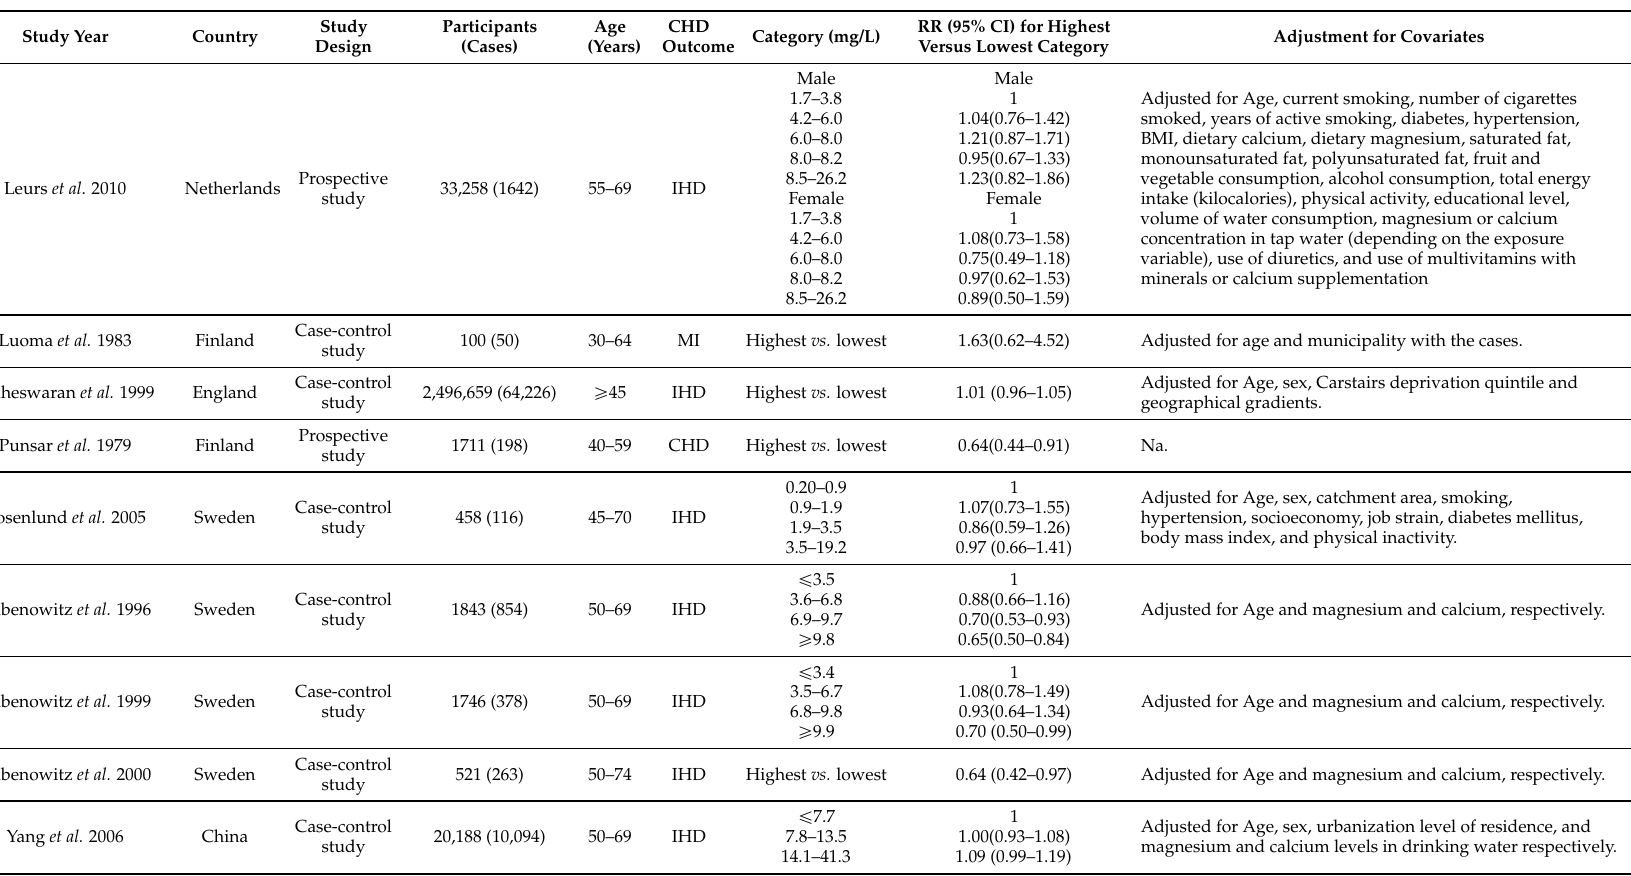
Table 1. Characteristics of studies on the levels of magnesium in drinking water and CHD mortality